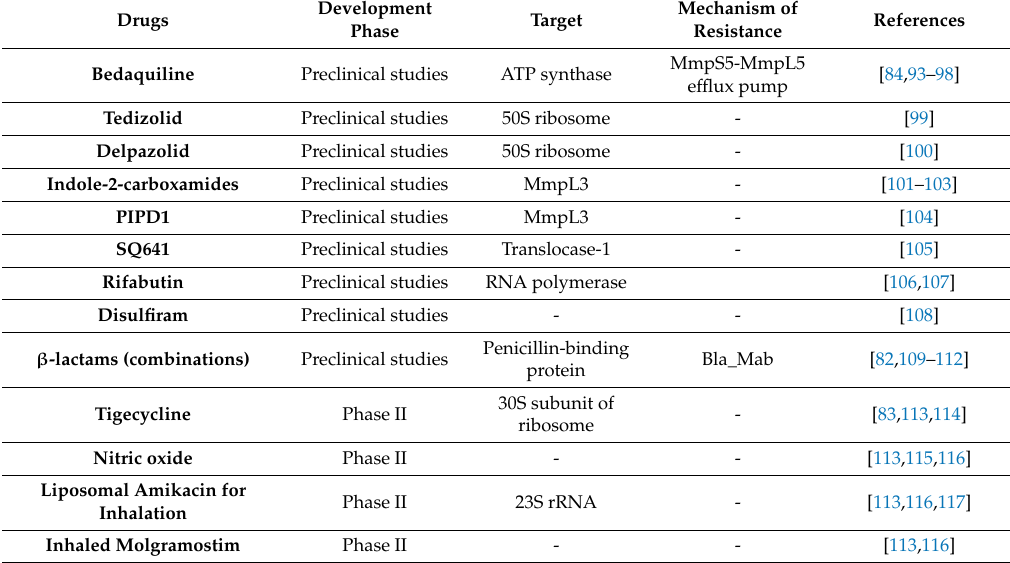
Table 2. Compounds in preclinical and clinical development against Mab